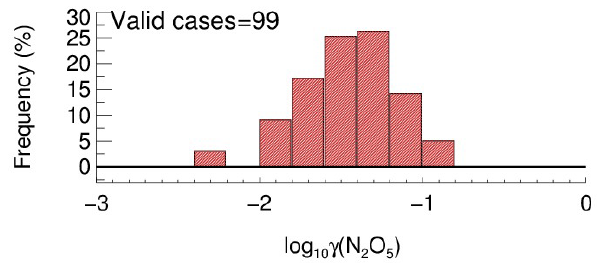
Figure 13. The histogram distribution of measured γ( N 2 O 5 ) for valid cases.